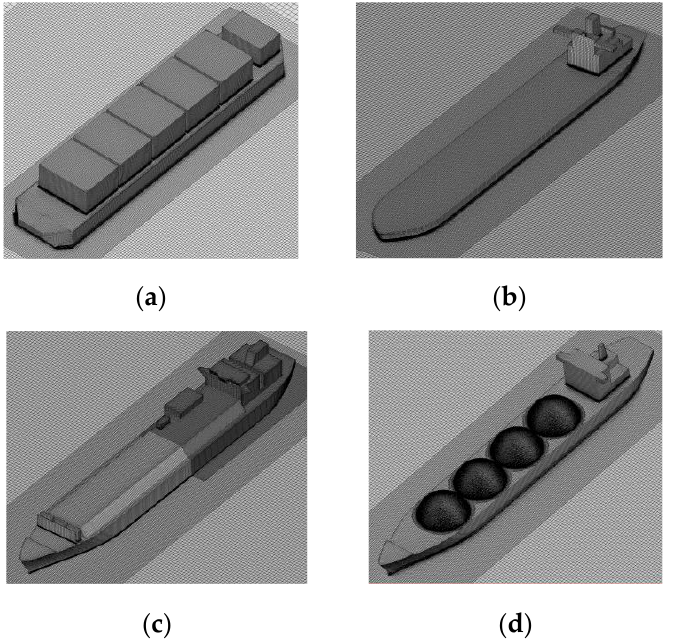
Figure 5. Computational grid system for wind load on offshore vessels. ( a ) FPSO; ( b ) Shuttle tanker; ( c ) Membrane-type LNGC; ( d ) Moss-type LNGC. Table 2. Computational meshes used for CFD calculations.